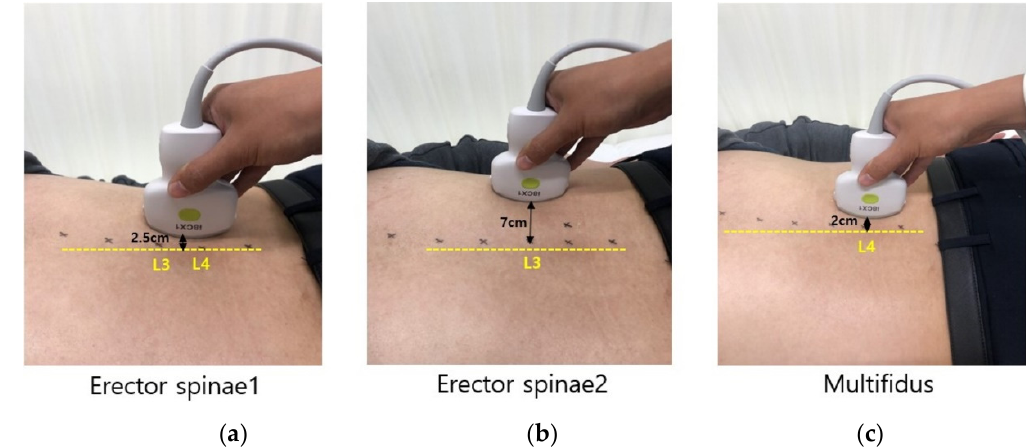
Figure 1. Location of ultrasound probe to measure skin thickness, muscle thickness, and shear-wave elastography (SWE). ( a ) Erector spinae 1; ( b ) erector spinae 2; and ( c ) multifidus.